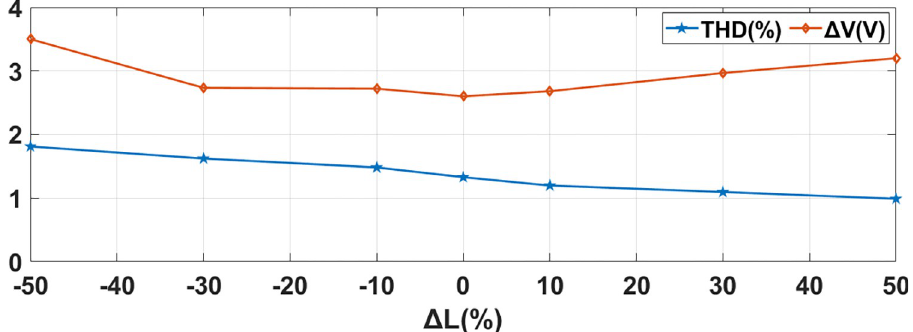
Fig 16. Sensitivity of proposed MPC controller to variations in inductor value for AC-DC Converter.